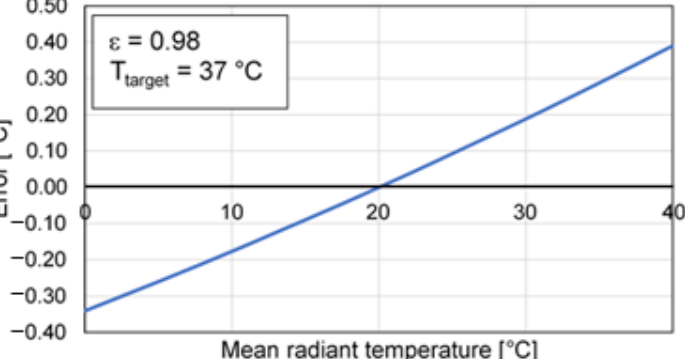
Figure 7. Error depending on the mean radiant temperature.